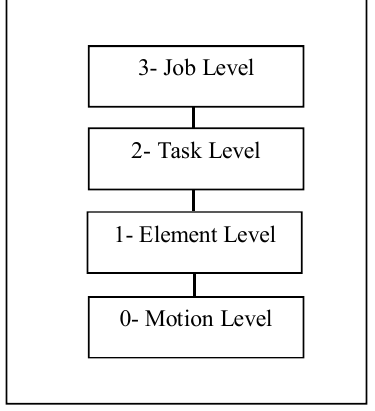
Fig. 8. Definitions of orders of work units